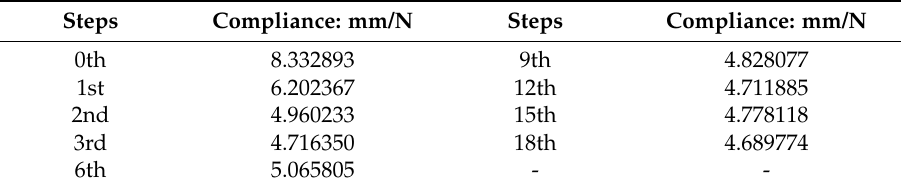
Figure 10. The objective function under static topological optimization conditions in iterations. Table 2. The optimized material mechanism flexibility parameters in iterations.